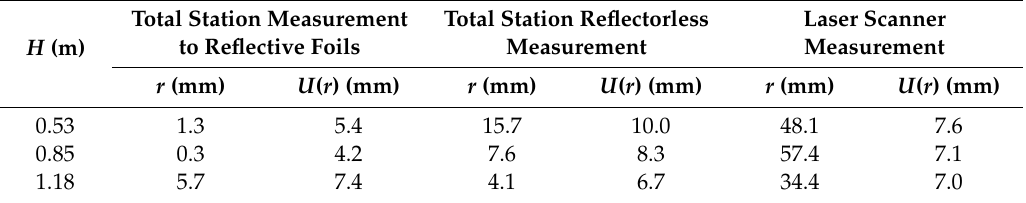
Table 2. Deviation of cross-section centers from a vertical line r and its expanded uncertainty U ( r ) for considered measurement